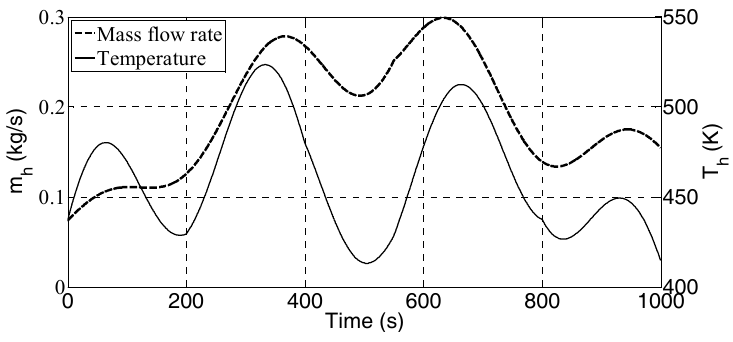
Figure 8. Heat source mass flow rate and temperature [28]. Table 3. Computation time for a transient heat source simulation.